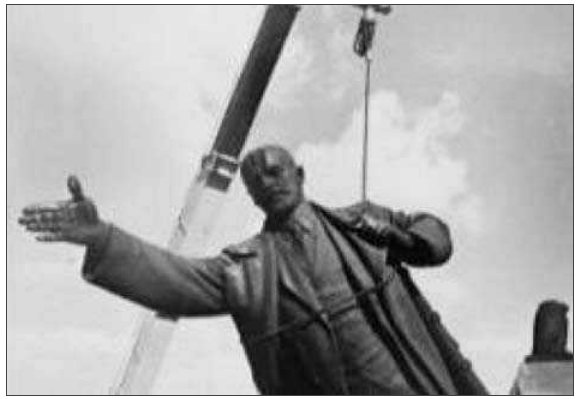
Fig. 8. context of Green bridge